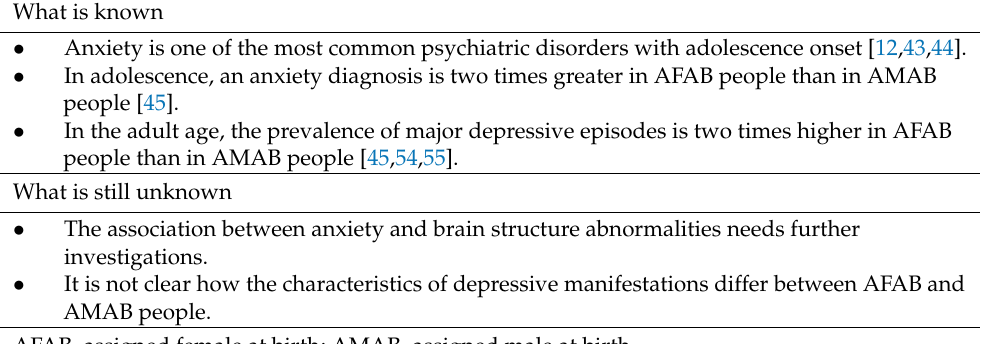
Table 2. Available evidence on the relationship between anxiety/depression and